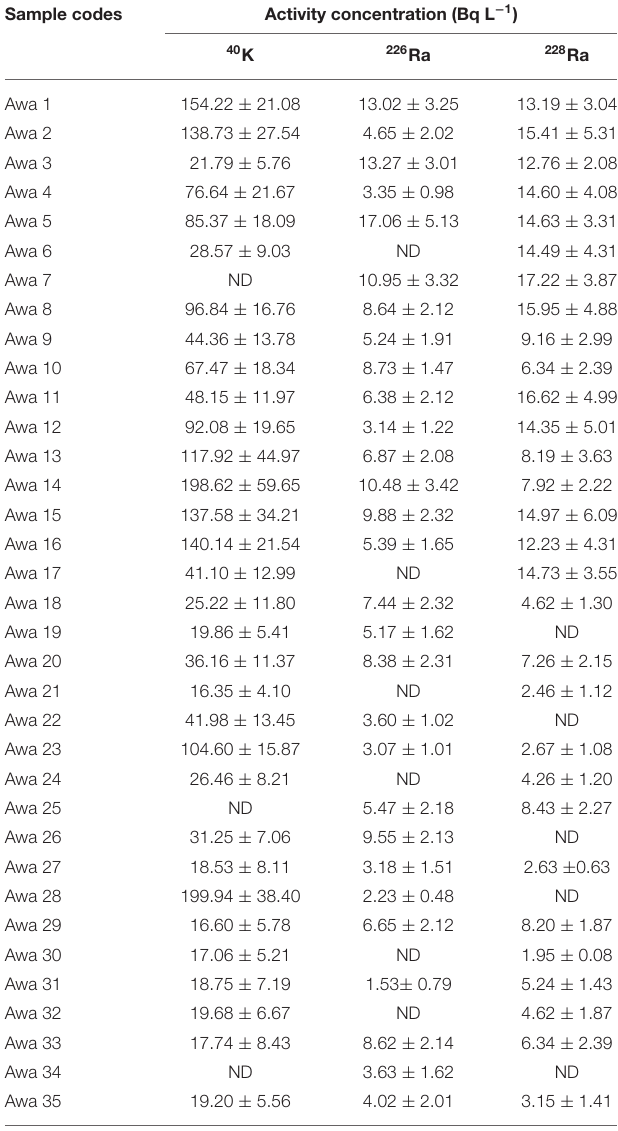
TABLE 1 | Activity concentrations of the radionuclides in the